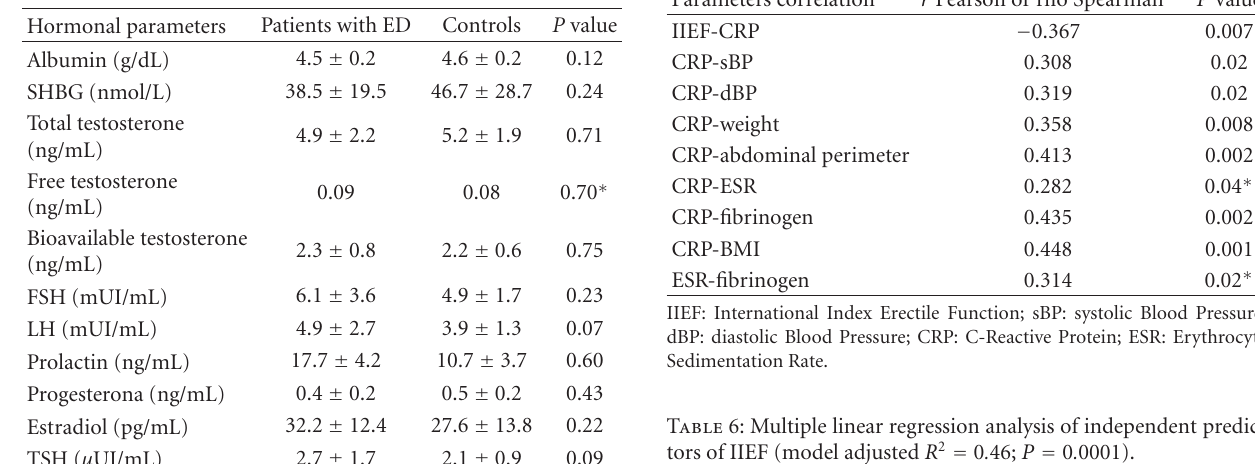
Table 5: Correlation between acute phase parameters and IIEF score or metabolic syndrome criteria.